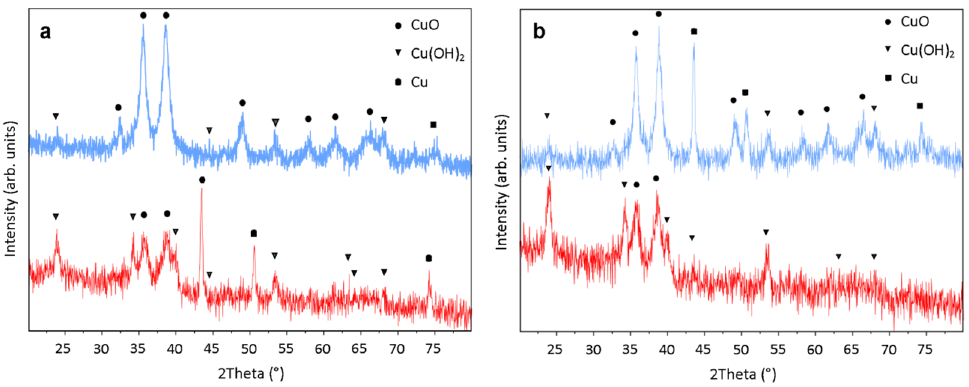
Figure 2. X-ray diffraction (XRD) patterns: ( a ) films grown in 0.033 M NH 3 solution for 48 h in a partially-covered system (red) and in a covered system (blue), ( b ) films grown in 0.066 M NH 3 solution for 48 h in a partially-covered system (red) and in a covered system (blue). These results are consistent with the visual assessment of the films and solutions.